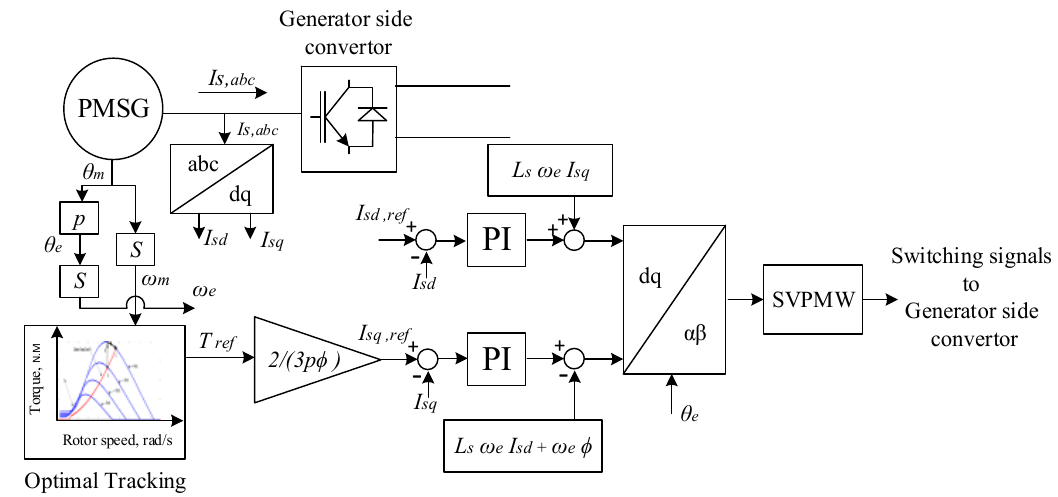
Figure 9. Control loops of a generator side converter with PMSG Wind turbine.